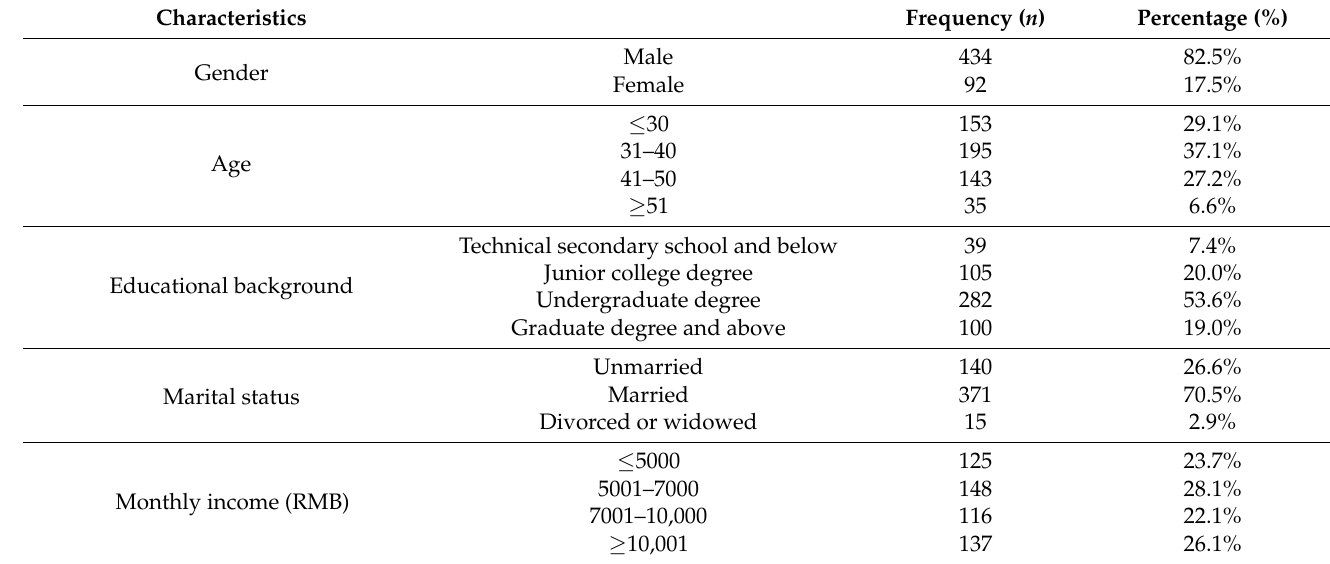
Table 1. Characteristics of study population and job burnout level (N =